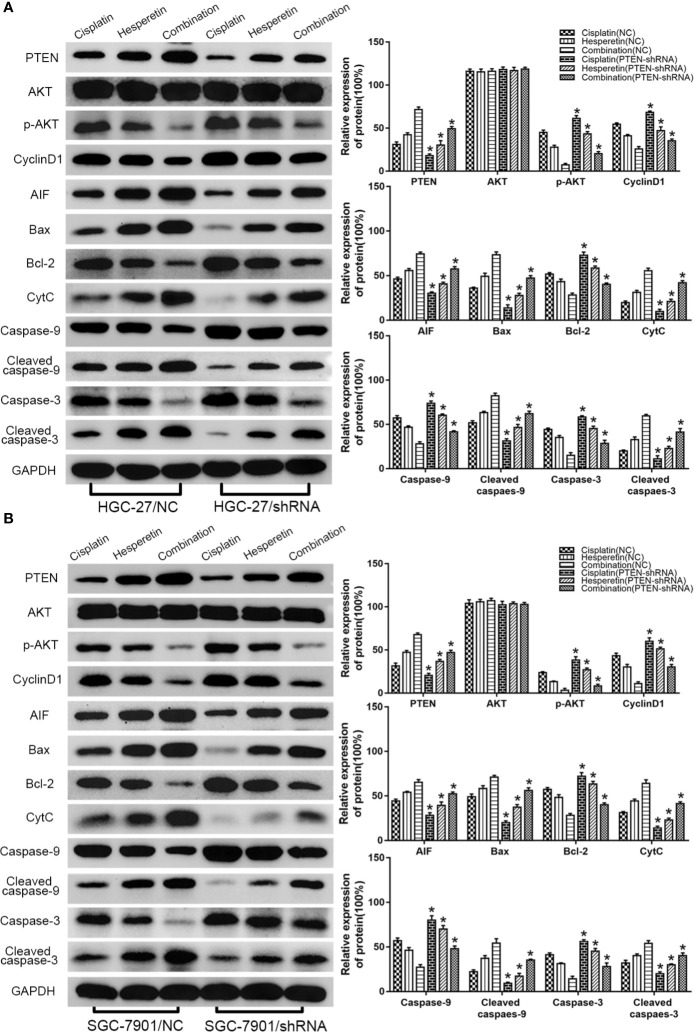
Downregulation of PTEN attenuates the apoptosis of GC cells induced by cisplatin and cisplatin combined with hesperetin. (A) HGC-27/NC and HGC-27/PTEN-shRNA cells were treated with 4 μg/ml cisplatin, 200 μM hesperetin, and 4 μg/ml cisplatin + 200 μM hesperetin, and western blotting was performed to detect the levels of related proteins. *P < 0.05 vs. the corresponding NC cells. (B) SGC-7901/NC and SGC-7901/PTEN-shRNA cells were also treated with cisplatin, hesperetin, and cisplatin + hesperetin, as described above; western blotting was performed to detect the levels of related proteins. *P < 0.05 vs. the corresponding NC cells. All the above data are the mean ± SD from an average of three experiments.